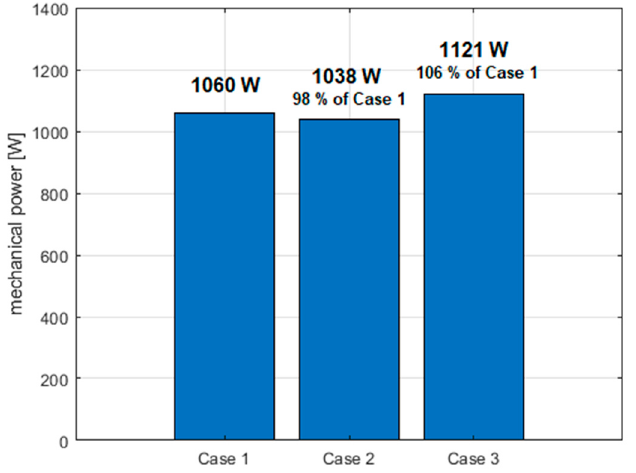
Figure 13. Mechanical power comparison of three simulations with different grid size and turbu- lence models.